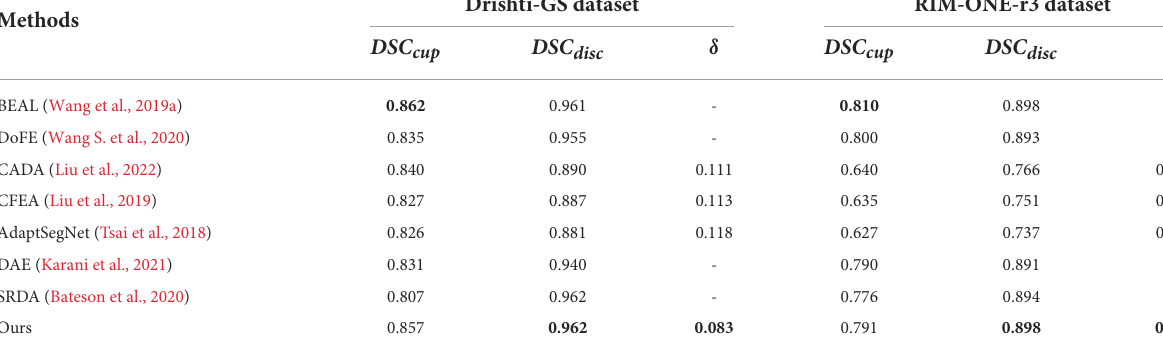
TABLE 3 Comparison of segmentation methods using domain adaptation.